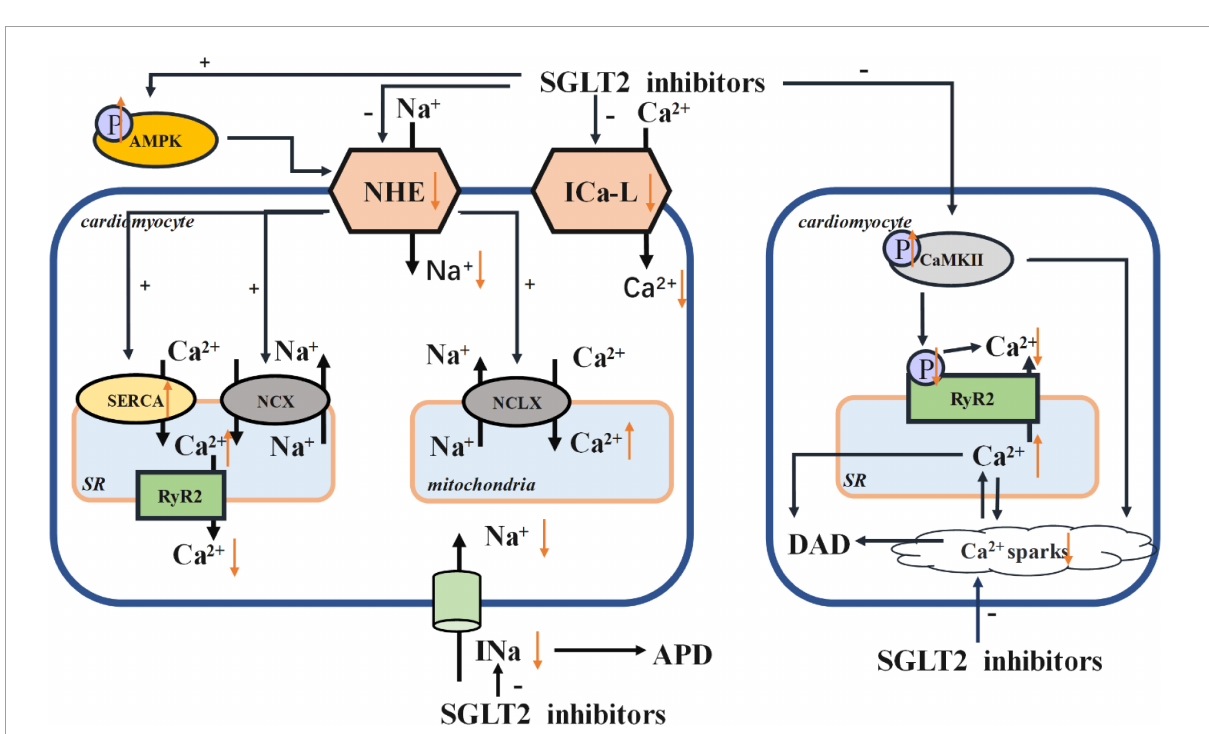
FIGURE1 Electrical remodeling. AMPK, adenosine monophosphate kinase; NHE, Na + /H + exchanger; NCX, Na + /Ca 2 + exchanger; NCLX, Na + /Ca 2 + exchanger; SR, sarcoplasmic reticulum; SERCA, sarco/endoplasmic reticulum Ca 2 + -ATPase; RyR, ryanodine receptor; ICa-L, L-type calcium channel; CaMKII, calcium/calmodulin-dependent protein kinase II; APD, action potential duration; DAD, delayed after